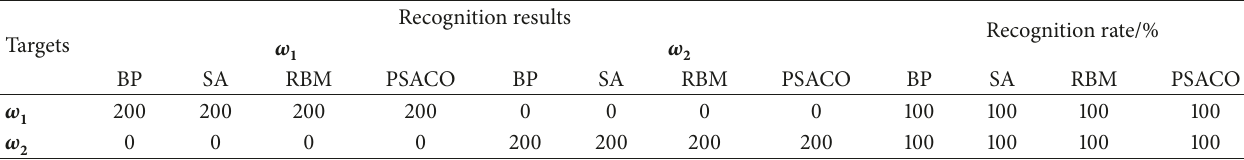
Table 4: Recognition results of CNIS-I for original sample.